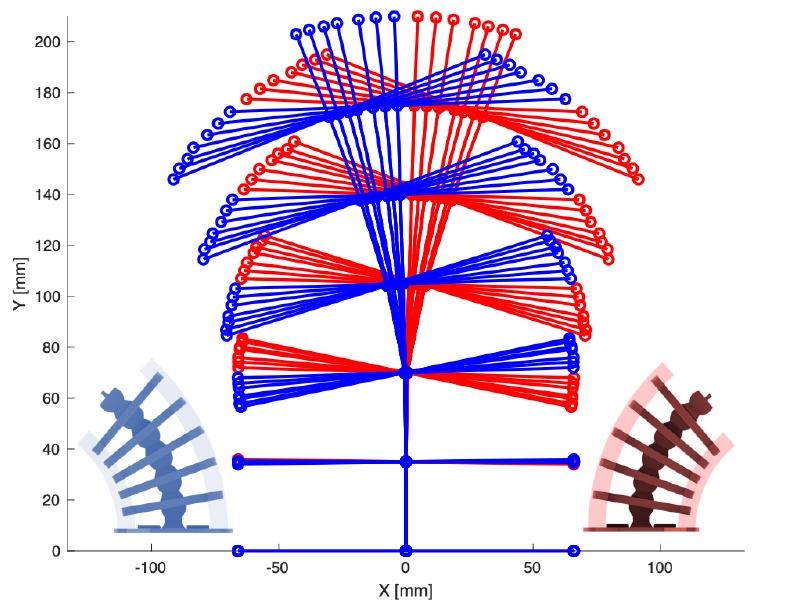
Figure 6. Using imaging analysis, displacements were obtained experimentally for each rigid segment at the center and at the rib endpoints (highlighted in markers). Right ( + X) and left ( − X) are shown in red and blue,